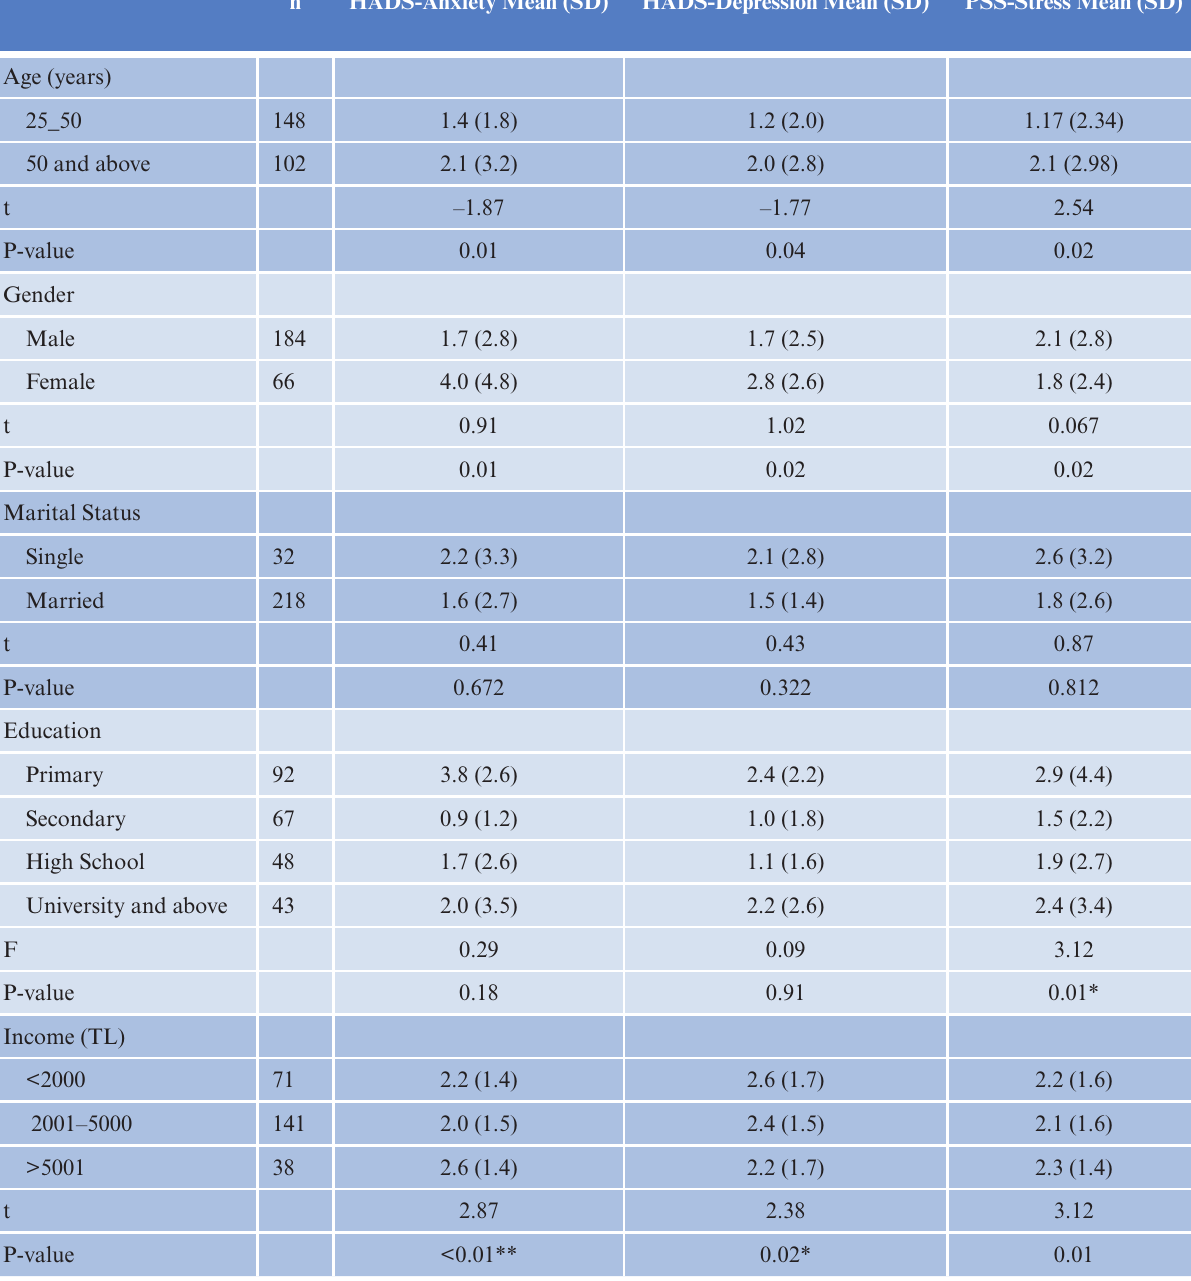
Table 3: Comparison of mean scores of HADS-Anxiety, HADS-Depression, PSS-Stress, and socio-demographic characteristics ( n =